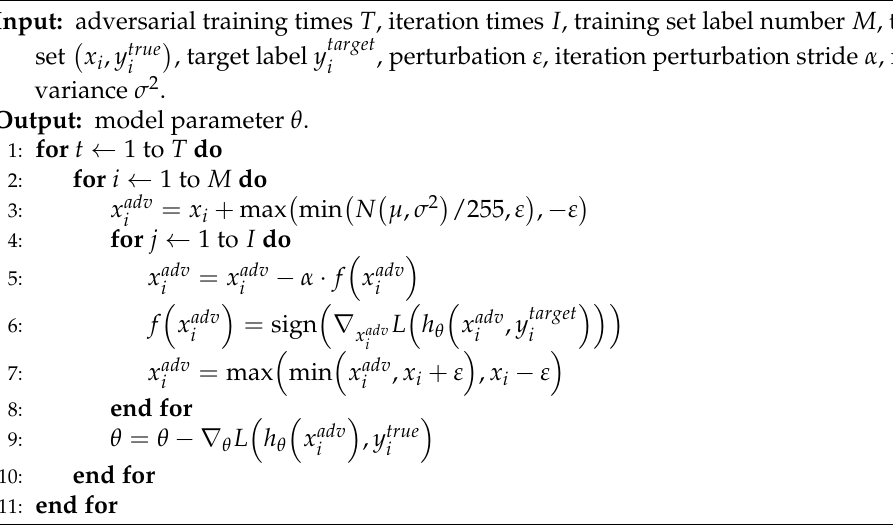
Algorithm 1 Universarial Adversarial